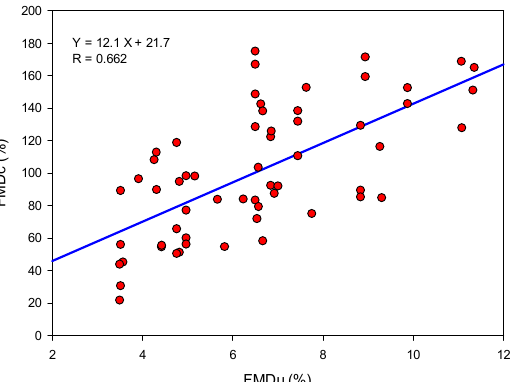
Figure 6. The linear regression between FMD u and FMD c with a correlation coefficient (R) of 0.662. Table 3. The results (mean ± standard deviation) of D B,max , D H,max , D B,min , and D H,min measured by BAUS.